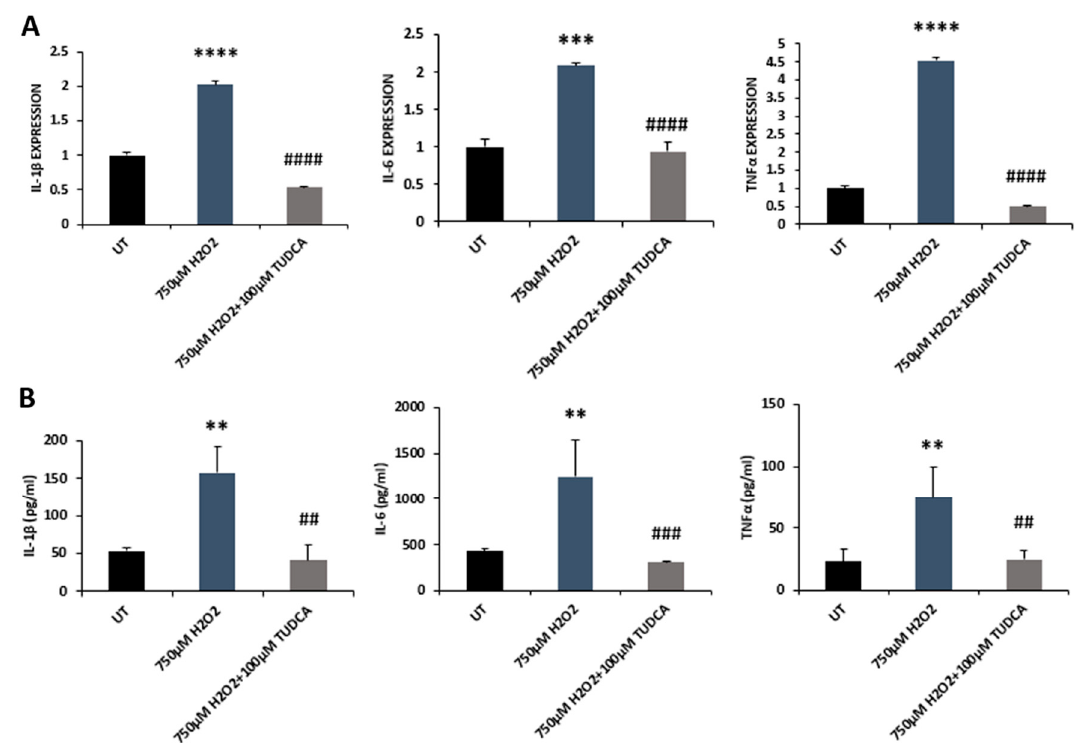
Figure 5. TUDCA suppressed H 2 O 2 -induced inflammation. ( A ) IL-1 β , IL-6, and TNF- α mRNA levels in control, H 2 O 2 , and H 2 O 2 -plus-TUDCA-treated cells were measured by qRT-PCR. ( B ) Protein concentrations of IL-1 β , IL-6, and TNF- α in control, H 2 O 2 , and H 2 O 2 -plus-TUDCA-treated cells were detected by ELISA. Data were shown as mean ± SEM. ** p < 0.01, *** p < 0.001, **** p < 0.0001, 750 µM H 2 O 2 vs. untreated (UT) control; ## p < 0.01, ### p < 0.001, #### p < 0.0001, 750 µM H 2 O 2 plus TUDCA vs. 750 µM H 2 O 2 .